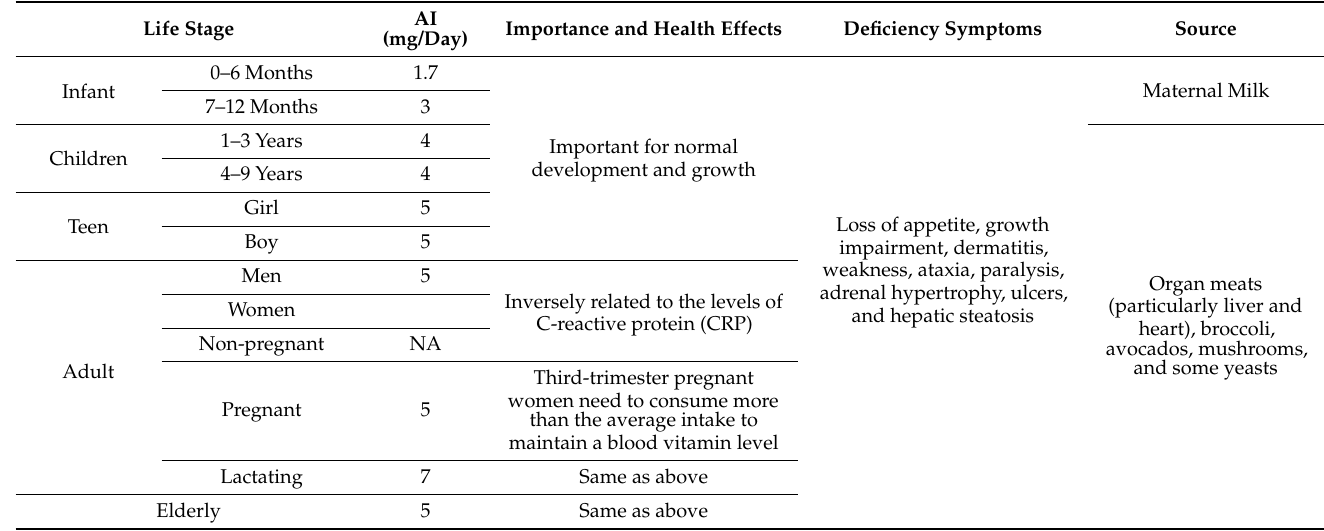
Table 4. Adequate daily intake (AI), main actions, and natural sources of vitamin B5 (pantothenic acid) in different life